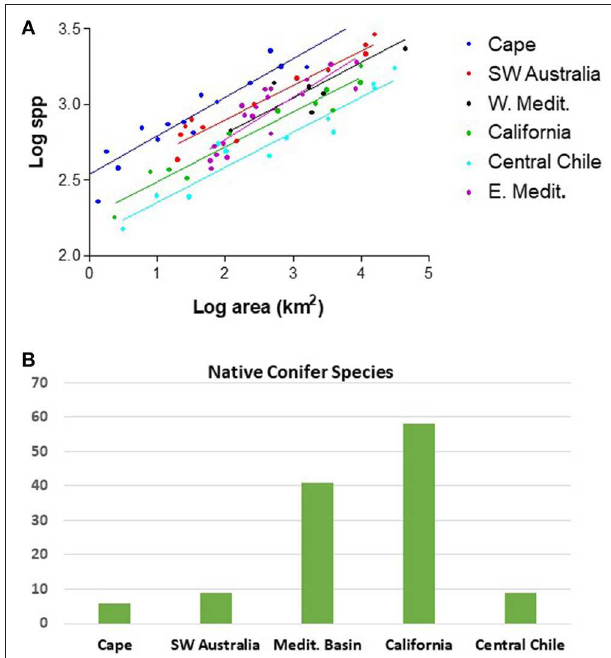
FIGURE 2 | (A) Log-log plot of native vascular plant species diversity vs. area for the five MTC regions, with the western and eastern Mediterranean Basin plotted separately (adapted from Cowling et al., 2015); (B) Native conifer species for each of the five MTC regions.